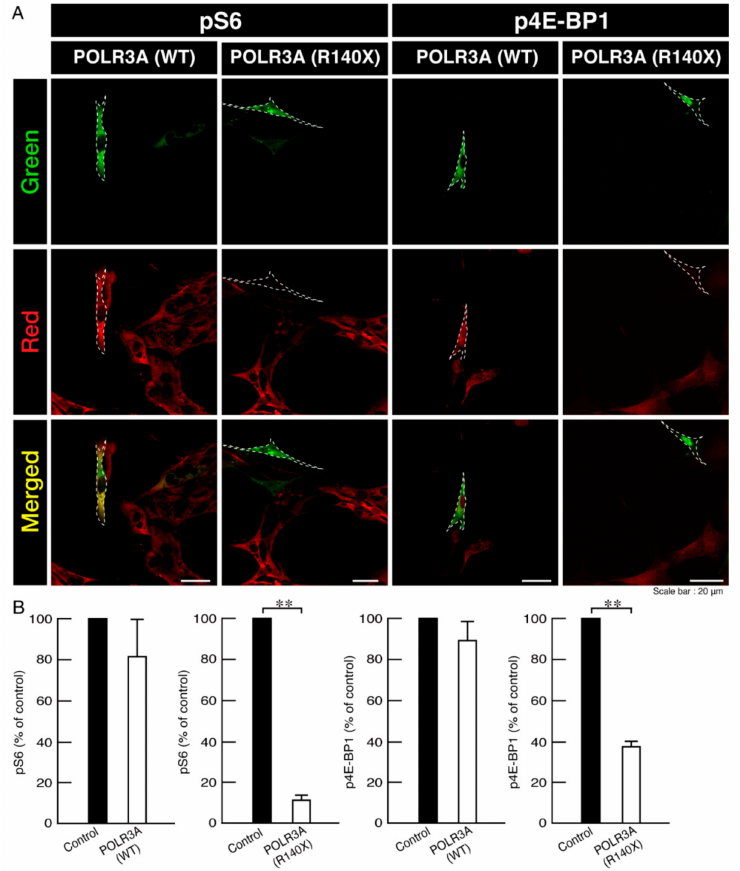
Figure 10. Cells harboring the POLR3A mutants, but not the wild types, decrease phosphorylation levels of ribosomal S6 and 4E-BP1 proteins. ( A , B ) FBD − 102b cells harboring the wild type (WT) or R140X construct (green) were stained with an anti-(pS240 and pS244) ribosomal S6 protein (pS6) or anti-(pT37)4E-BP1 (p4E-BP1) antibody (red) whose phosphorylation acts downstream of mTOR signaling. Their phosphorylation levels are shown statistically compared to those in their respective control cells under each image (** p < 0.01; n = 3